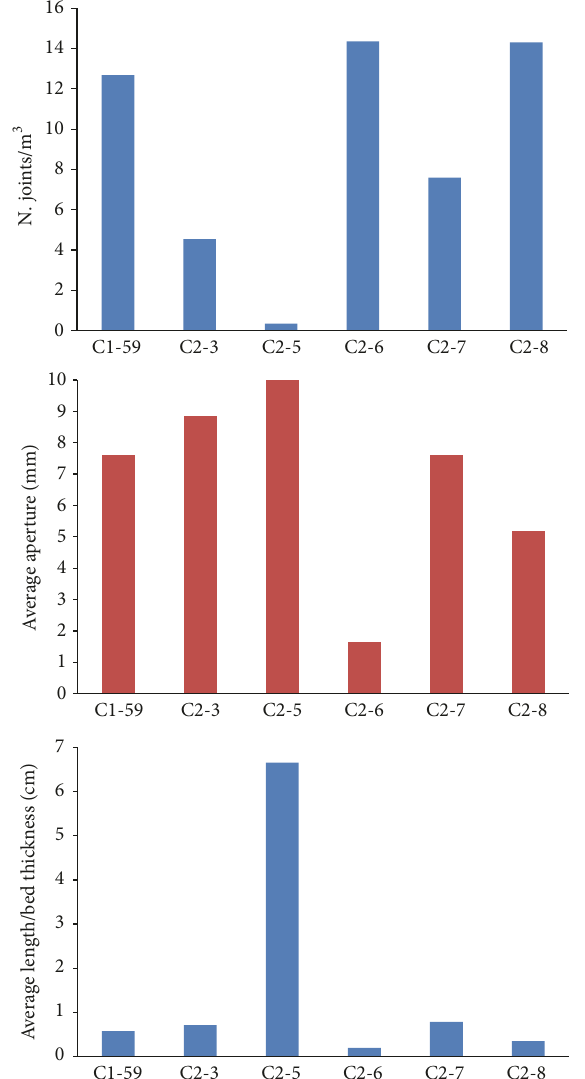
Figure 8: Joints features recorded with the scan line method.